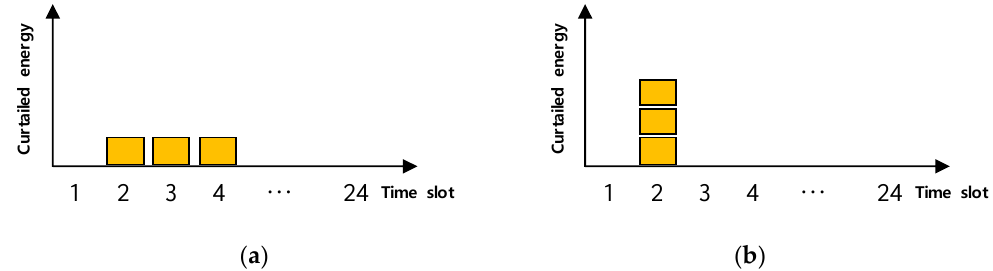
Figure 1. Energy curtailment ( a ) distributed evenly among multiple time slots and ( b ) concentrated in a single time slot.